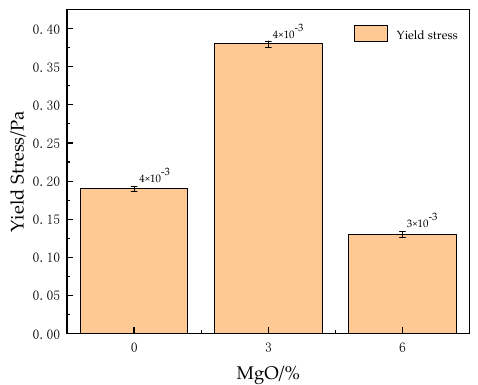
Figure 7. Plastic viscosity of the fresh paste. Figure 6. Yield stress of the fresh paste. Figure 6. Yield stress of the fresh paste. Figure 6. Yield stress of the fresh paste.